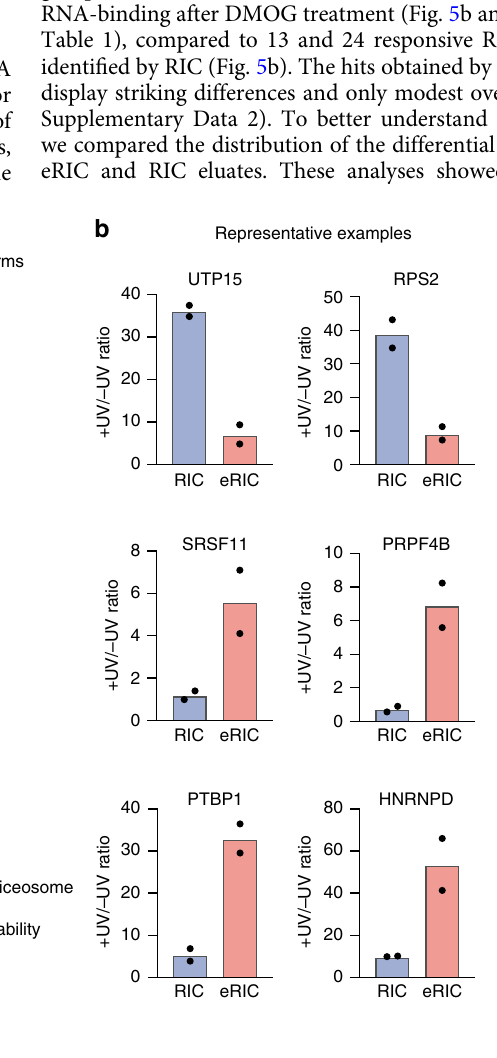
Fig. 4 Differential RBP enrichment with eRIC. a Unsupervised clustering and GO analysis of proteins whose enrichments in irradiated ( + UV) over non- irradiated ( − UV) samples differ signi fi cantly between eRIC and RIC (FDR < 0.05 (moderated t test) and FC > 2, 144 proteins). Three main clusters are observed that comprise RBPs preferentially recovered by RIC (top) or eRIC (middle and bottom). Note that proteins in the middle and bottom clusters markedly differ in their enrichment over background in RIC samples. Biological process GO terms enriched for each cluster are shown. Upper: “ ribosome biogenesis ” ( − log10 ( p value) = 39.95; enrichment = 40.6), middle: “ mRNA processing ” (18.36; 14.85), bottom: “ mRNA splicing via spliceosome ” (33.48; 52.4), “ mRNA transport ” (8.52; 30.85) and “ regulation of mRNA stability ” (4.04; 17.08) (Fisher ’ s Exact with FDR multiple test correction). b Fold change in irradiated over non-irradiated samples of representative example RBPs captured by eRIC and RIC. Data correspond to two biologically independent experiments ( a , b ); in b , data are shown as